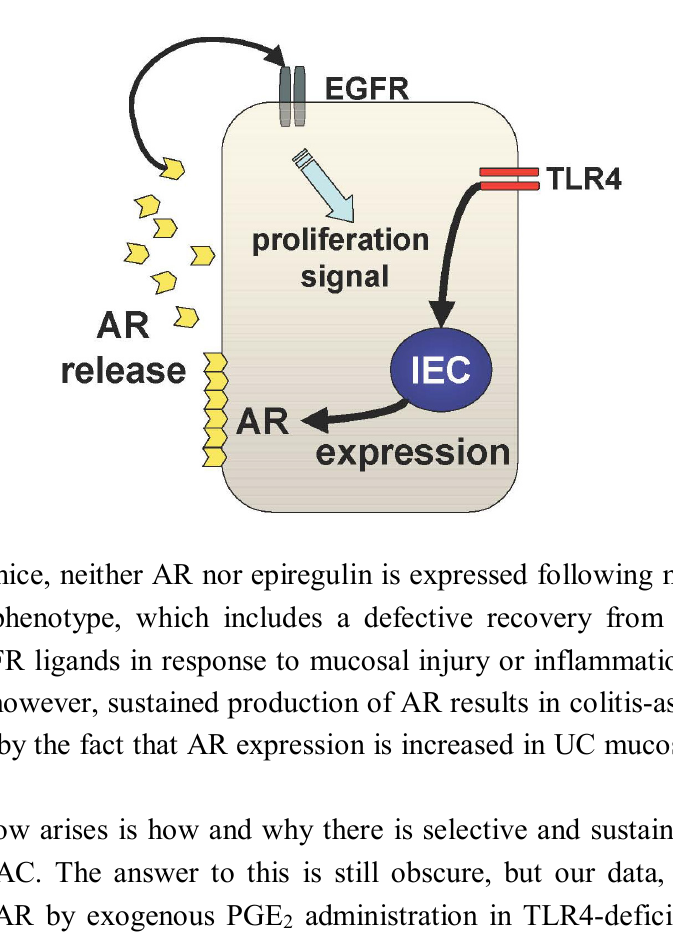
Figure 3. The TLR4-AR-EGFR axis. TLR4 signaling in intestinal epithelial cells induces the expression and release of AR, an EGFR ligand. Released AR binds to the EGFR in an autocrine and paracrine fashion. EGFR signaling is associated with increased proliferation of the epithelial